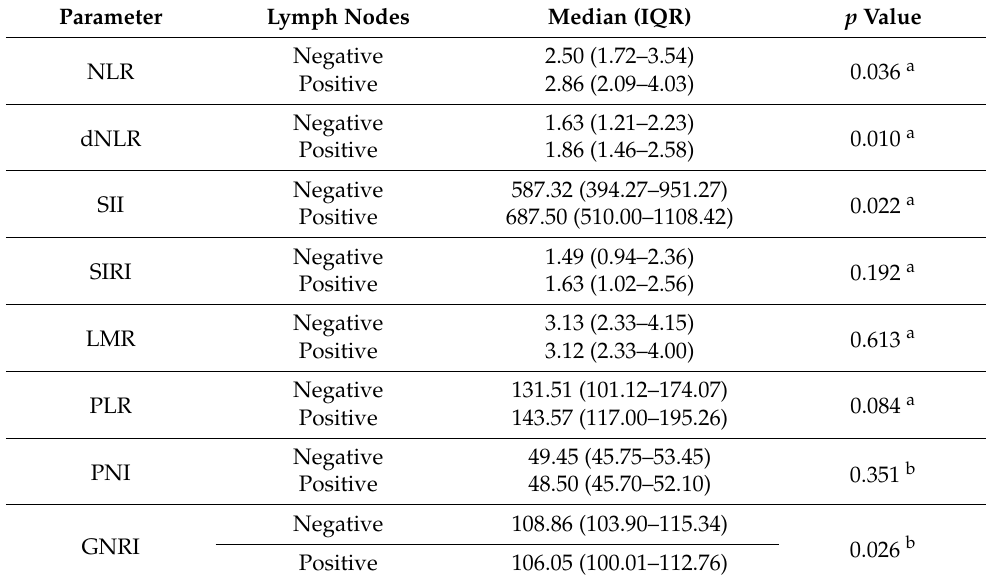
Table 8. Associations of inflammatory and nutritional parameters with the status of the lymph nodes.